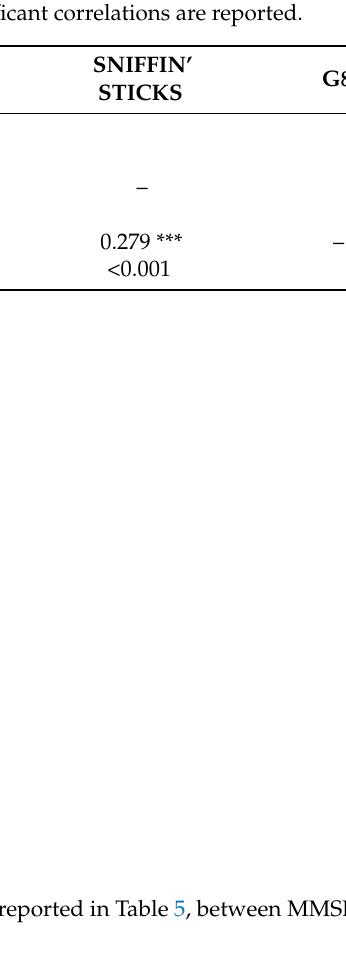
Figure 3. Raincloud plot showing the Sniffin’ Test scores of Group 1 (i.e., chemotherapy; ChT), Group 2 (i.e., immunotherapy; ImT) and Group 3 (i.e., geriatric control group). Patients treated with immunotherapy showed lower scores ( p = 0.05) compared to chemotherapy and controls. Conventions as in Figure 1.